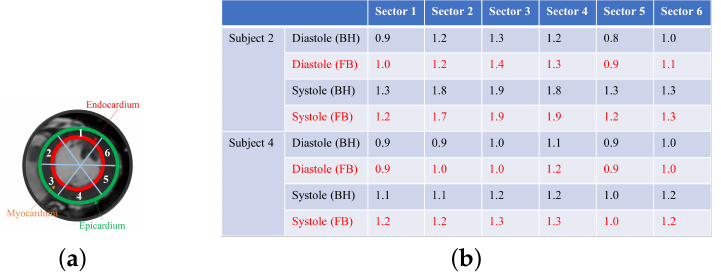
Figure 9. ( a ) The six sectors of the myocardium. ( b ) Comparison of the area of each sectors from FB and BH (cm 2 ). Left ventricle wall analysis. We compared the areas of the six sectors of the myocardium obtained from the generated cine and the breath-hold cine. From the quantitative results in the table, we can see that the generated cine using the proposed scheme is able to provide results similar to those of the breath-hold